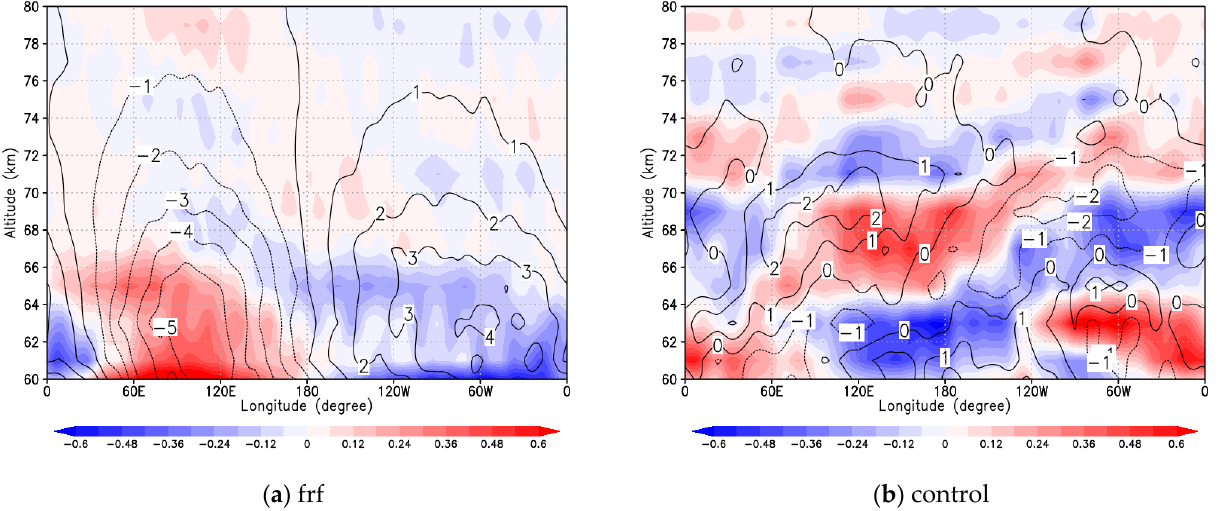
Figure 5. Longitude – altitude cross-sections of composite means of zonal wind (m/s; contour) and temperature (K; color) deviations from their zonal averages at the equator for the ( a ) frf and ( b ) control cases. Each field is averaged along with periods of 5 and 4 Earth days for the frf and control cases to extract the Rossby and Kelvin waves, respectively.